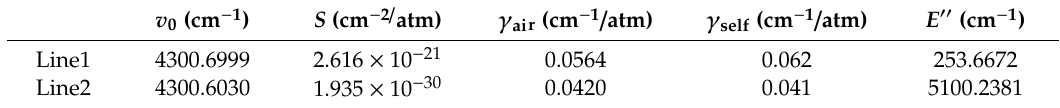
Table 1. Line pair information for CO molecule near 4300 cm − 1 used in this paper (296